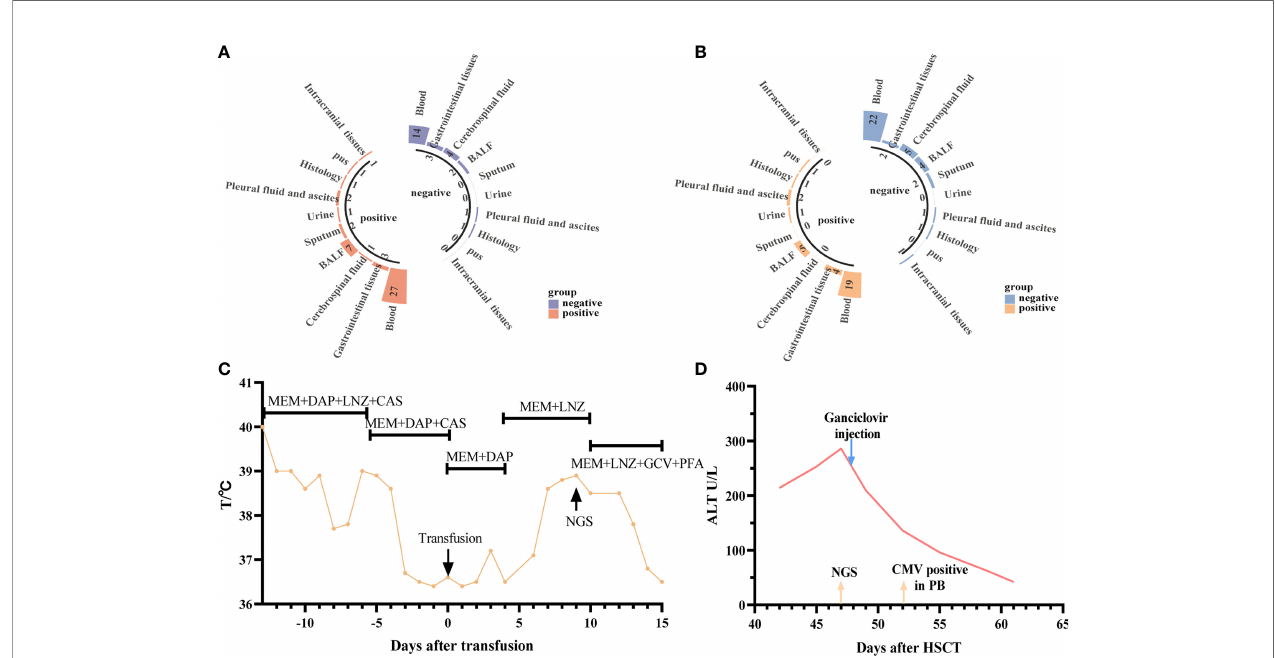
FIGURE 5 | Diagnostic value of NGS and CMT in different specimens. (A, B) Respectively shown that the positive microbiological detection rate of NGS and CMT using different specimens (C) representative case 1. A 5-year-old male patient with SAA developed a fever after hematopoietic stem cell (HSC) infusion. Meropenem and Daptomycin was given based on previous treatments but the symptom was not improved after 7 days of treatment. The CMT had negative results both blood and urine. Then the anti-infective regimen was adjusted according to NGS results (HHV-6B), which was obtained at +9d. After 7-day ’ s therapy the patient ’ s symptoms were improved; (D) representative case 2. A 22-year-old female patient with SAA developed low fever and persistent ALT elevation, and had no positive results in various laboratory tests. The liver puncture was performed, she was diagnosed with CMV infection (liver) based on the results from NGS at +47d. And then modi fi ed as soon as the NGS results were obtained (Ganciclovir). After only 5 days, CMV copy number was detected in peripheral blood. The patients ’ symptoms were fi nally improved.